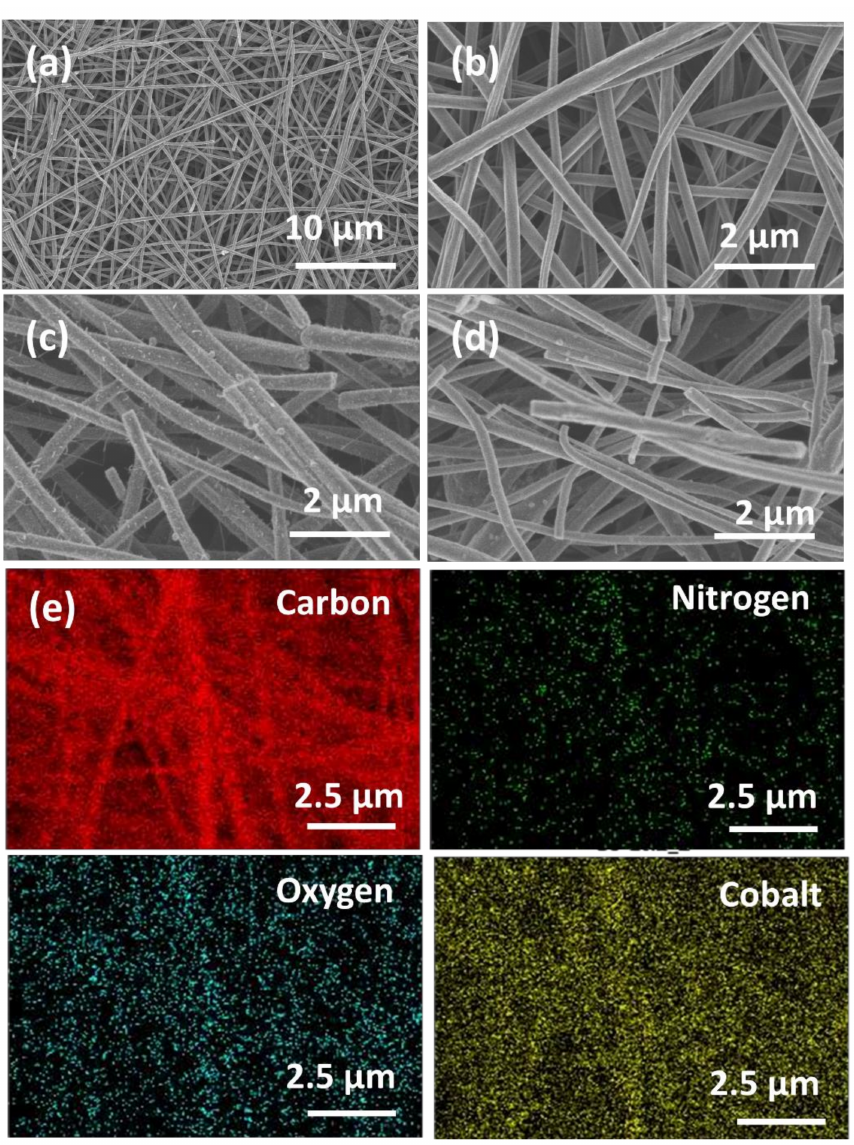
Figure 1. Field emission scanning electron microscopy images (FESEM) of the indicated CNF electrodes: ( a ) CNF; ( b ) CNF-Co3; ( c ) CNF-Co10; ( d ) CNF-Co20; and ( e ) SEM-EDX elemental mapping of carbon, nitrogen, oxygen, and cobalt in